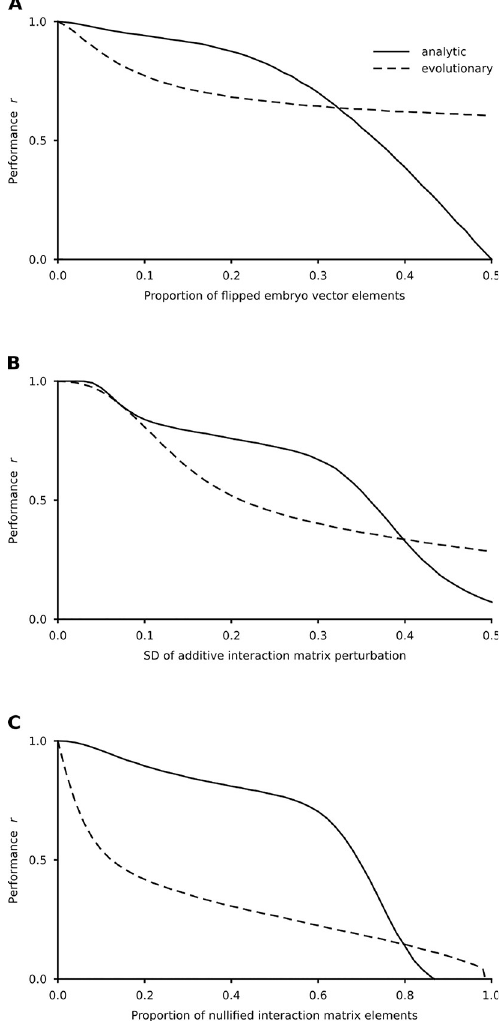
Fig 7. Robustness of the developmental dynamics against perturbations. The interaction matrices were constructed from the given number of embryo-adult vector pairs according to Eq (4). The performance was expressed by the Pearson correlation(s) between the desired and the experienced adult state(s) for all developmental pathways after T = 150 iterations averaged over 300 matrices and 100 perturbations for each parameter combination. (A ) Performance against the proportion of the flipped embryonic vector elements. (B ) . Performance against the standard deviation ( SD ) of the perturbation of the interaction matrix. All elements of the matrix were perturbed additively by an N (0, SD ) random number. (C ) Performance against the proportion of nullified elements of the interaction matrix. Each element of the interaction matrix was set to zero with the given probability. Relevant parameters are as in Fig